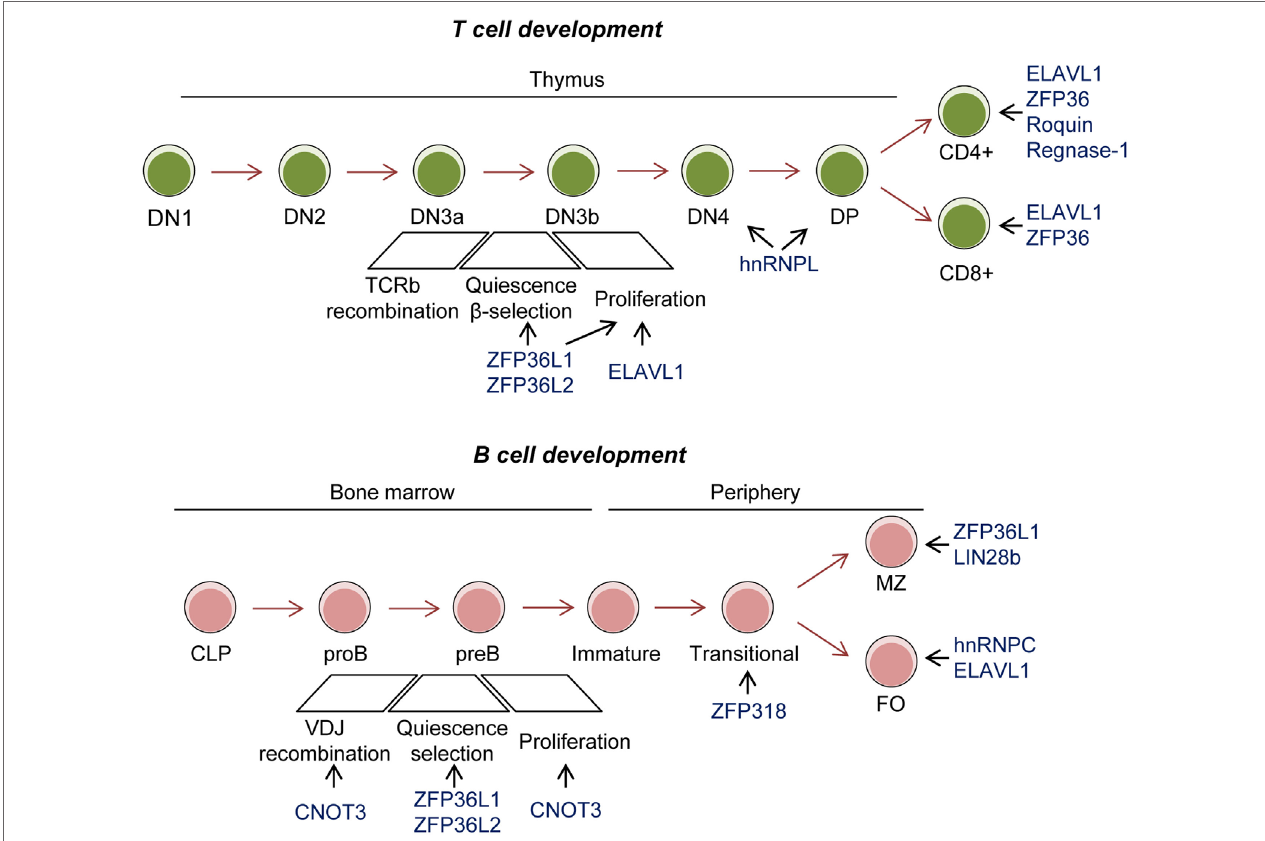
FiGURe 2 | Role of RNA-binding proteins (RBPs) in T- and B-cell development. Conditional mouse models have revealed the importance of the RBP ZFP36L1 and ZFP36L2 in cell quiescence upon VDJ recombination to test and positively select those cells that have successfully recombined the BCR and TCR. C-NOT3 is related to successful VDJ recombination. These three RBPs and ELAVL1 are implicated in later expansion of double negative (DN) 3–4 T cells. ELAVL1, ZFP36, Roquin, and Regnase-1 are implicated in activation and differentiation of single positive T cells. ZFP318 is involved in IgD expression in transitional T2 B cells. ZFP36L1 and LIN28b have been involved in marginal zone (MZ) B-cell differentiation. hnRNPC and ELAVL1 are implicated in follicular (FO) B-cell